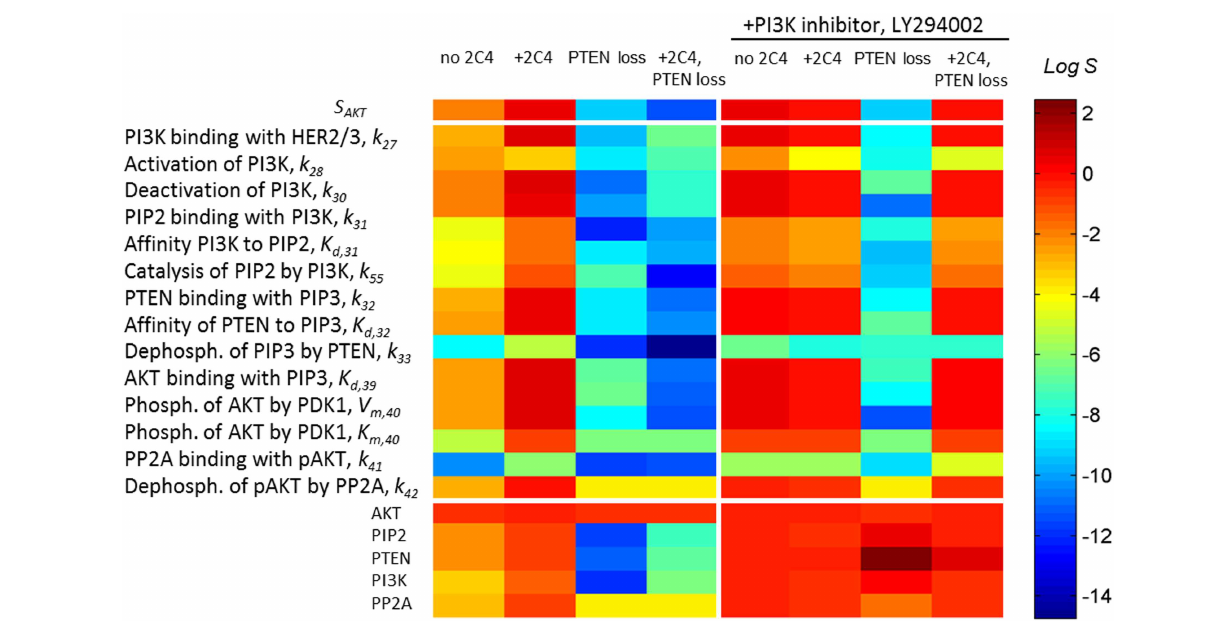
FIGURE 4 |A change in sensitivities S AKT and S AKT,p following different perturbations in the PI3K/PTEN/AKT network . Heatmap of sensitivity S AKT to p HER23 signal (upper heatmap) and sensitivity S AKT,p to kinetic parameters (middle heatmap) and initial protein concentrations (lower heatmap) at normal functioning of the SN (column 1), in the presence of 100nM 2C4 (column 2),